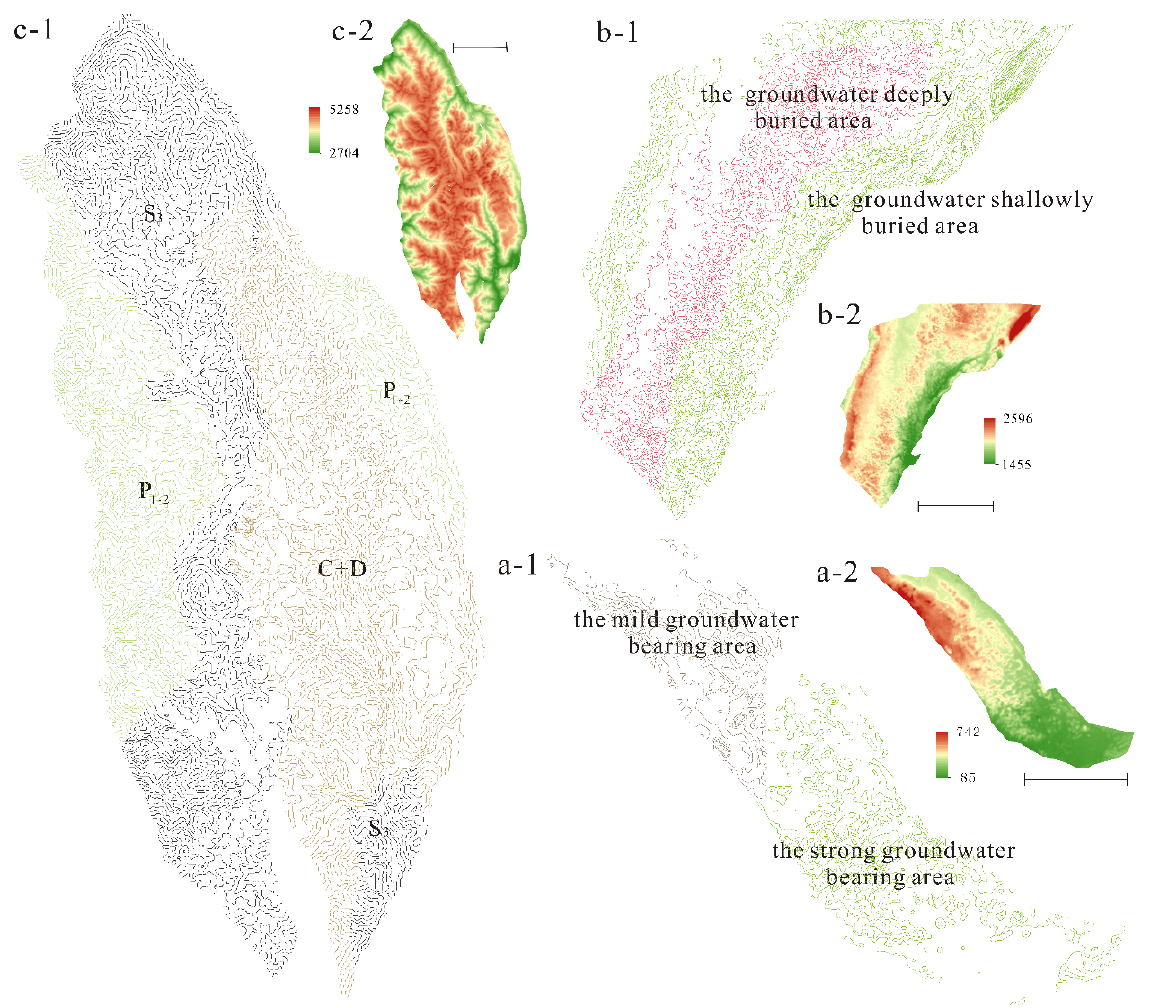
Figure 10. The altitude distribution and the contours in three typical study areas (the data come from the SRTMDEM 90M given by Geospatial Data Cloud, and these data are used to obtain the fractal Dimensions). ( a-1 , a-2 ) are for Pingguo System, which is divided into the strong groundwater bearing area and mild groundwater bearing area. ( b-1 , b-2 ) are for Dongfeng System, which is divided into deeply buried groundwater and shallowly buried groundwater. ( c-1 , c-2 ) are for Batang system, which is divided into a strong water-bearing stratum (C + D), a moderate water-bearing stratum (S), and the weak water-bearing stratum (P 1-2